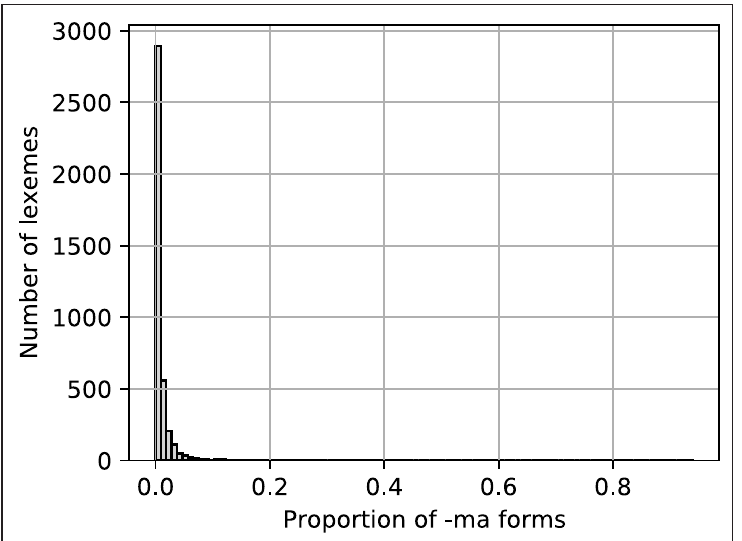
Figure 3 Histogram of the by-lexeme proportion of use of - ma forms of the ins.pl for overabundant nouns with a token cell frequency of 100 or more, in the SYN